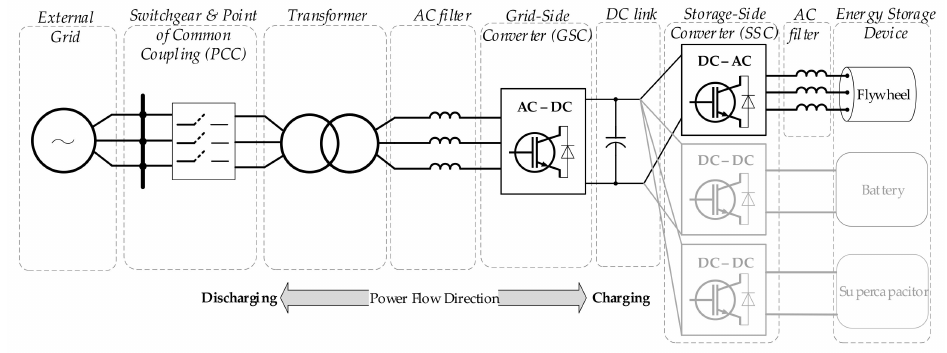
Figure 3. General configuration of the power conversion system involving di ff erent energy storage systems adapted from reference